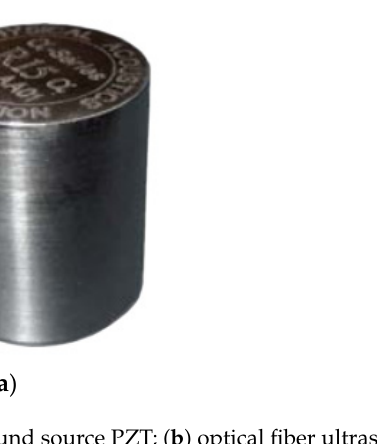
The acoustic source PZT continuously emits ultrasonic signals of a fixed amplitude